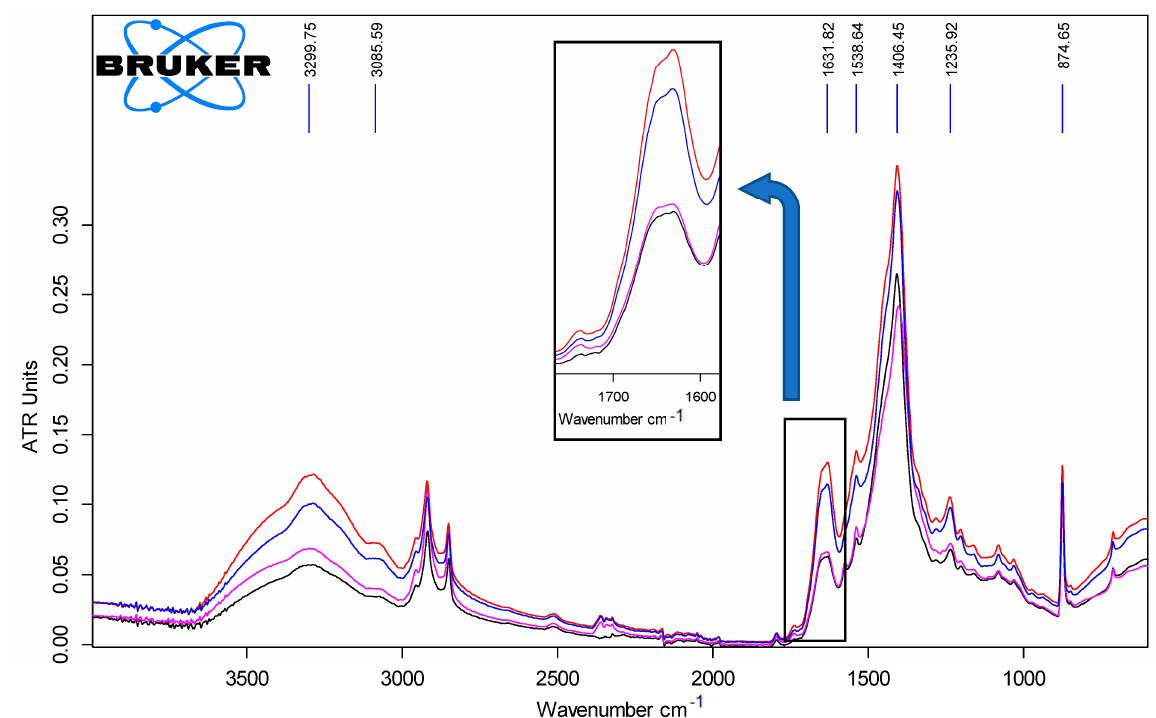
Figure 3. ATR spectra for non-irradiated (control) batches from head area (A to D batches); red, blue, and magenta curves depict samples near the backbone, and black curve depicts the sample farthest from backbone; inset with the amide I band depicting modification of the helix and random coil components, e.g., left and right maxima of the amide I band. The ATR spectra from the tail area are shown in Figure 4 for the unirradiated control batches. The same behavior with the head samples is observed for the tail area samples, e.g., the decrease in the intensity of organized helix structures is depicted by the left max- imum, and increase in random coil and unorganized structures is depicted by the right amide I band maximum for samples farthest of the backbone. In conclusion, there is no difference in behavior related to the decrease in the mechanical properties of the parch- ment from the backbone to the belly area for the tail and head areas.